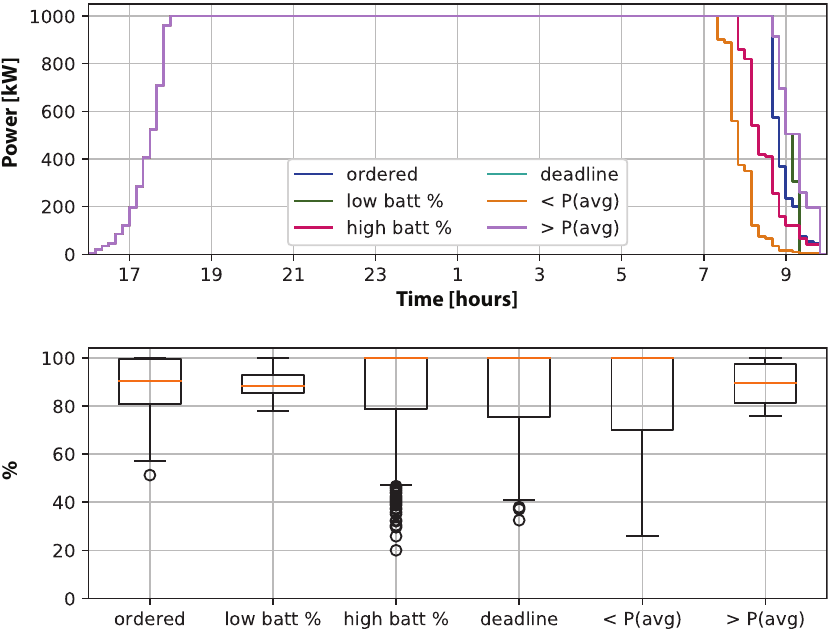
Figure 6. Power profile from 4 p.m. to 10 a.m. in the following day ( top ) and the distribution of battery level ( bottom ) for the “hard”